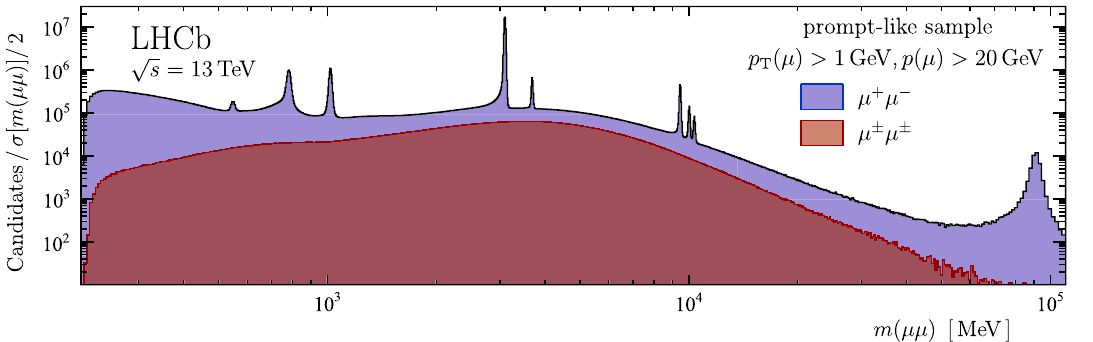
Fig. 4 Spectrum of prompt dimuon pairs recorded by LHCb, with background contributions indicated, from Ref. [54] Fig. 5 Upper limits at 90% confidence level on the production cross-section times branching fraction (cid:2) (cid:3) σ( X ) B X → μ + μ − obtained from an inclusive search for displaced X → μ + μ − decays, from Ref. [56]. Limits are shown as a function of the mass of the hypothesised X particle and its transverse